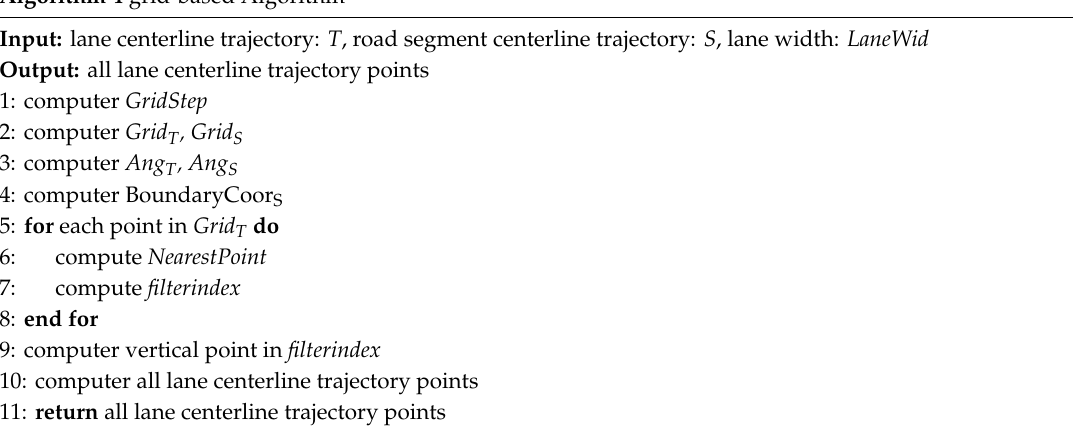
Algorithm 4 grid-based Algorithm